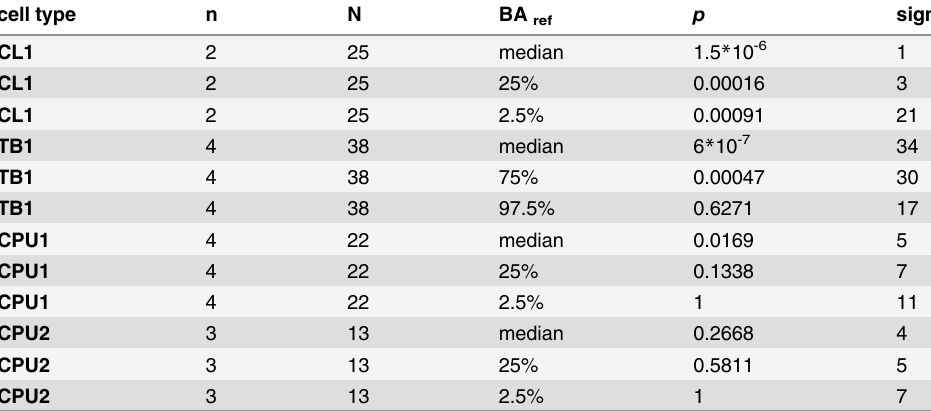
Table 3. Statistics of data distributions shown in Fig 6c.